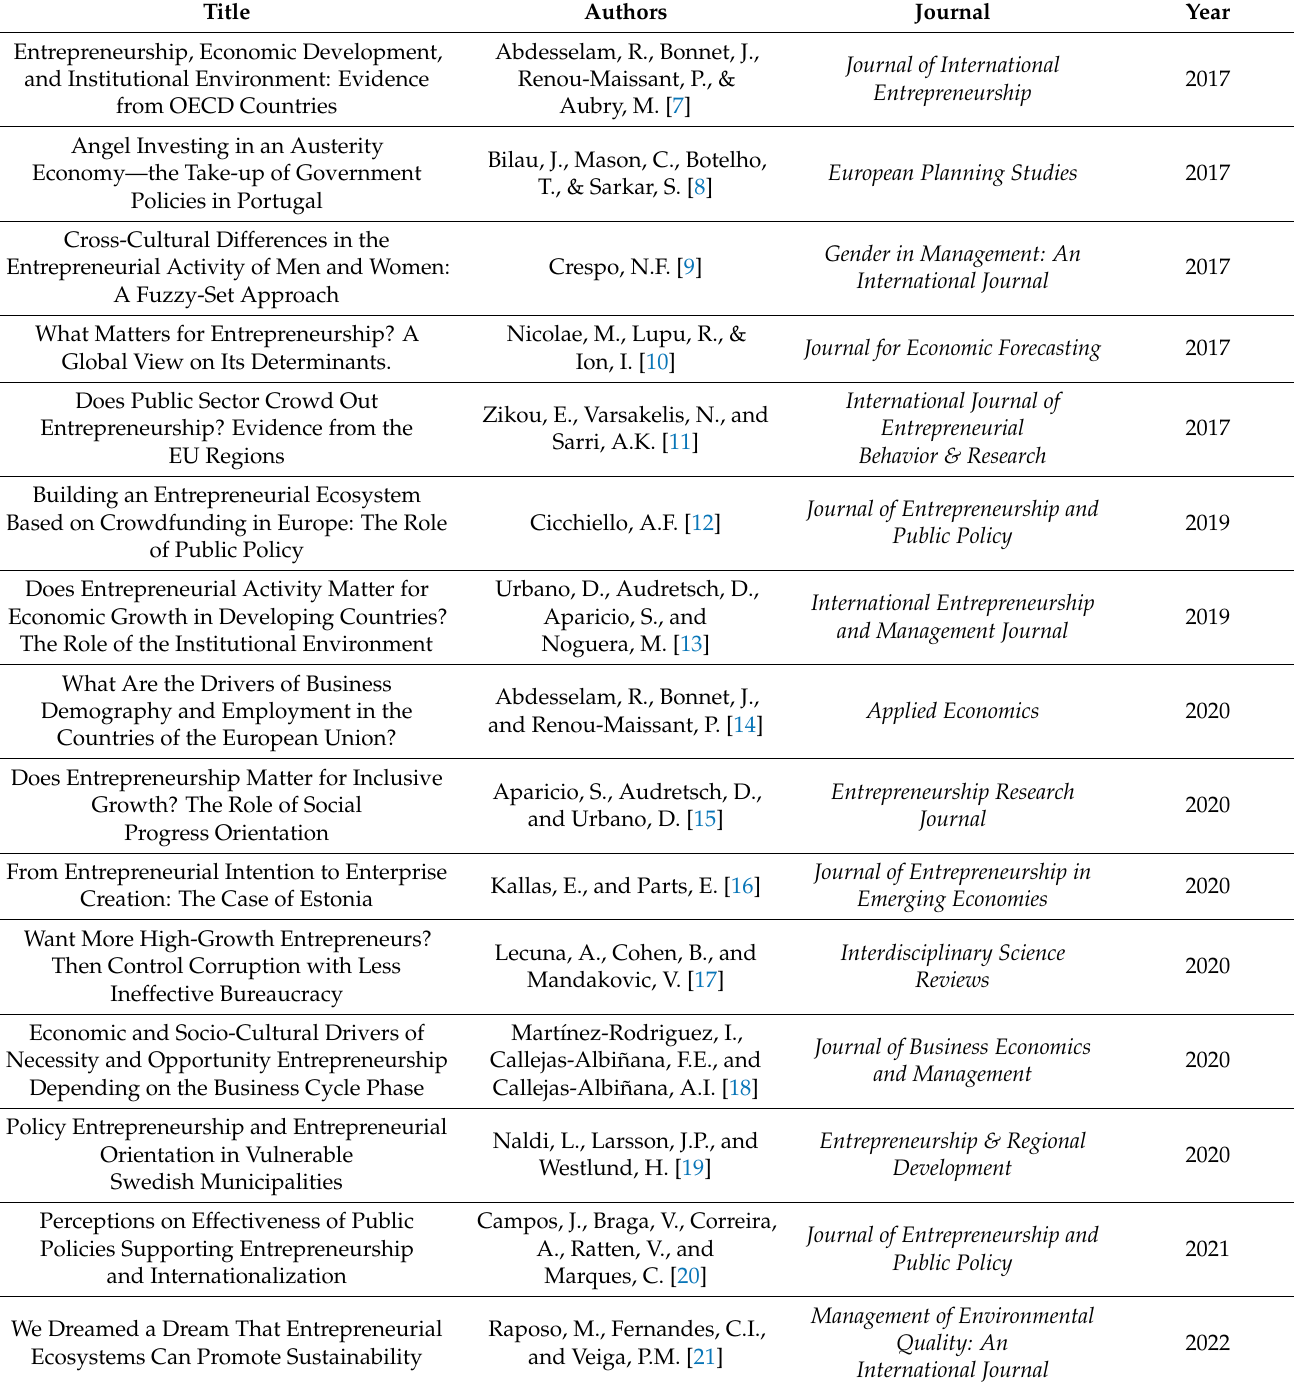
Table 1. Relevant articles on the relationship between public policy, entrepreneurship, and en- trepreneurial